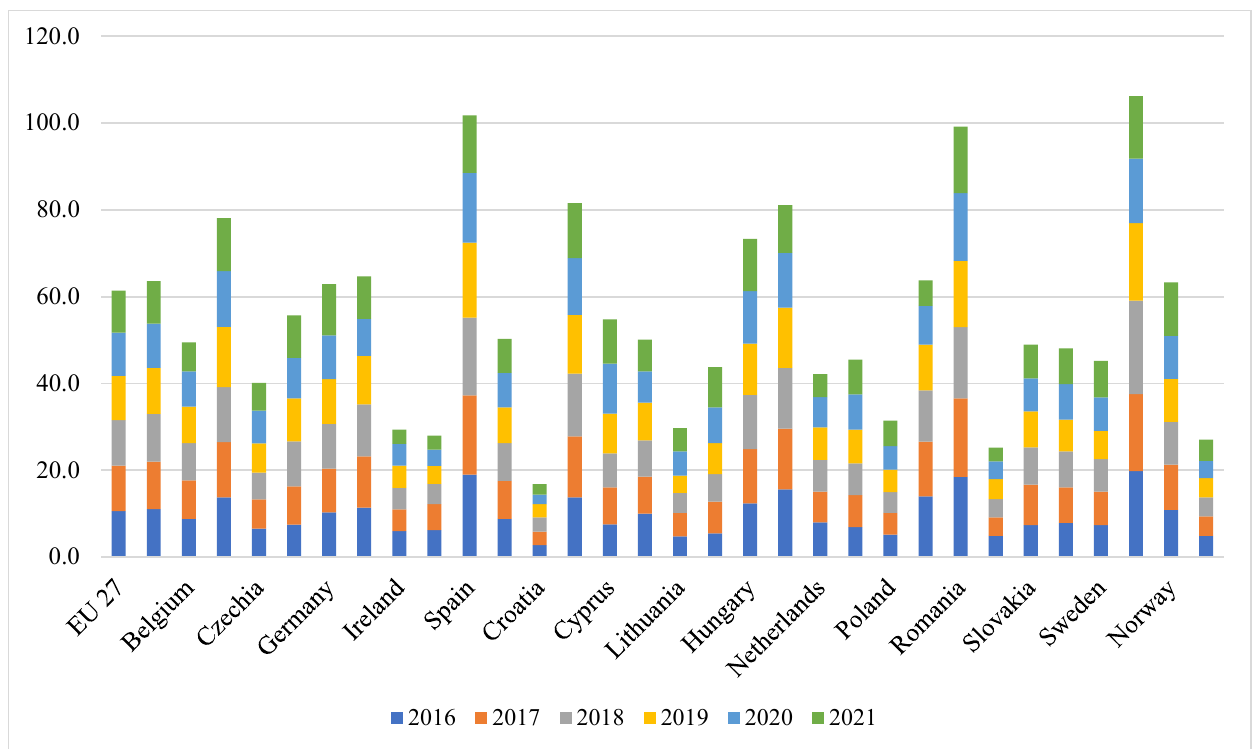
Figure 10. Early leavers from education and training in Europe, 2016–2021. Source: own elaboration on the Eurostat database.